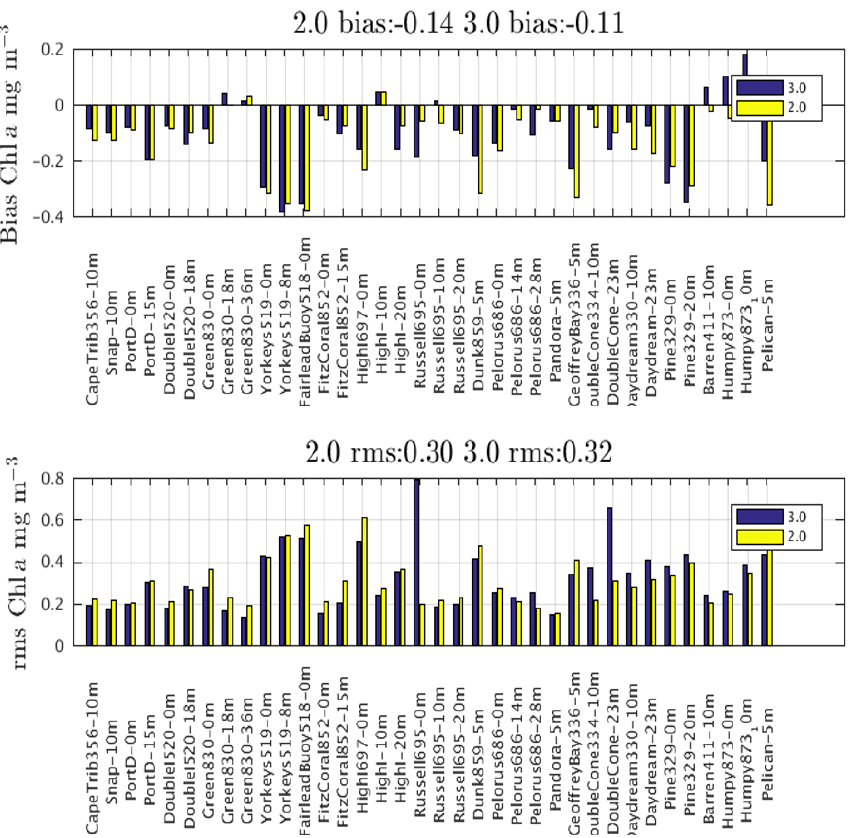
Figure 15. Skill metrics for the comparison of chlorophyll extracts at the long-term monitoring sites against observations for model versions 2p0 and 3p0. For more information, see Fig. 14 and S5, Sect. 10.